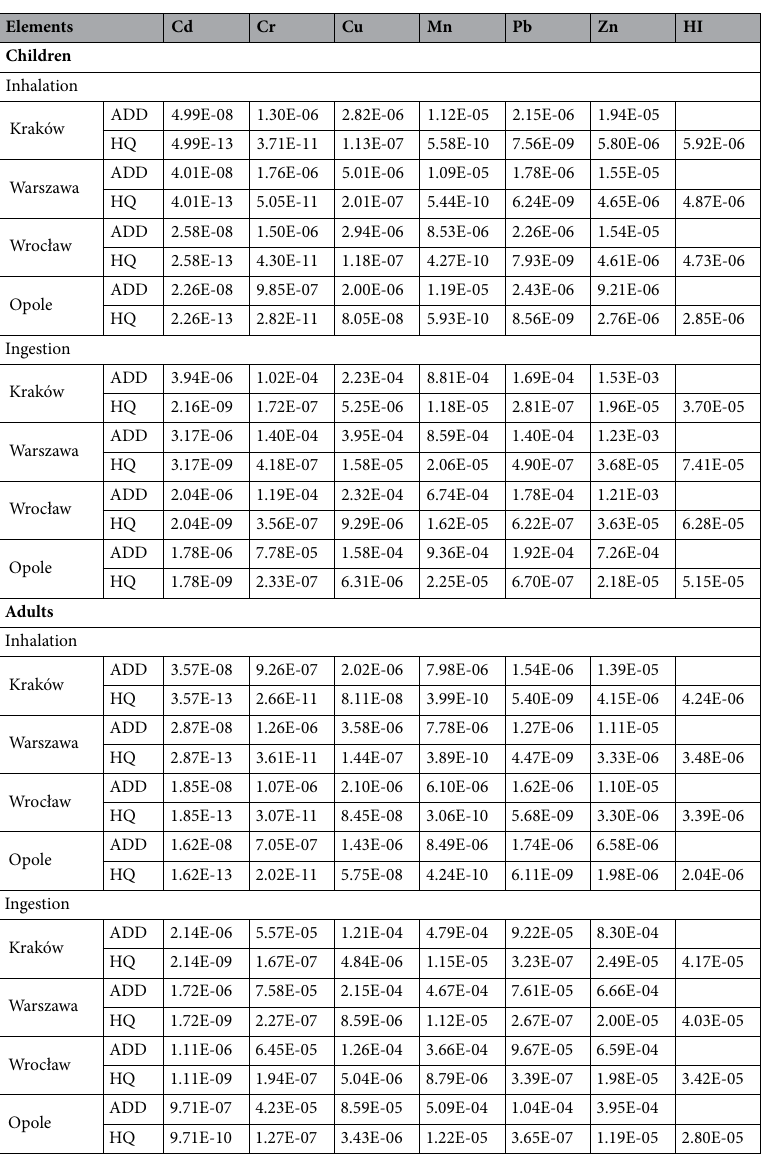
Table 5. Noncancerogenic human health risk estimation for children and adults with bike path